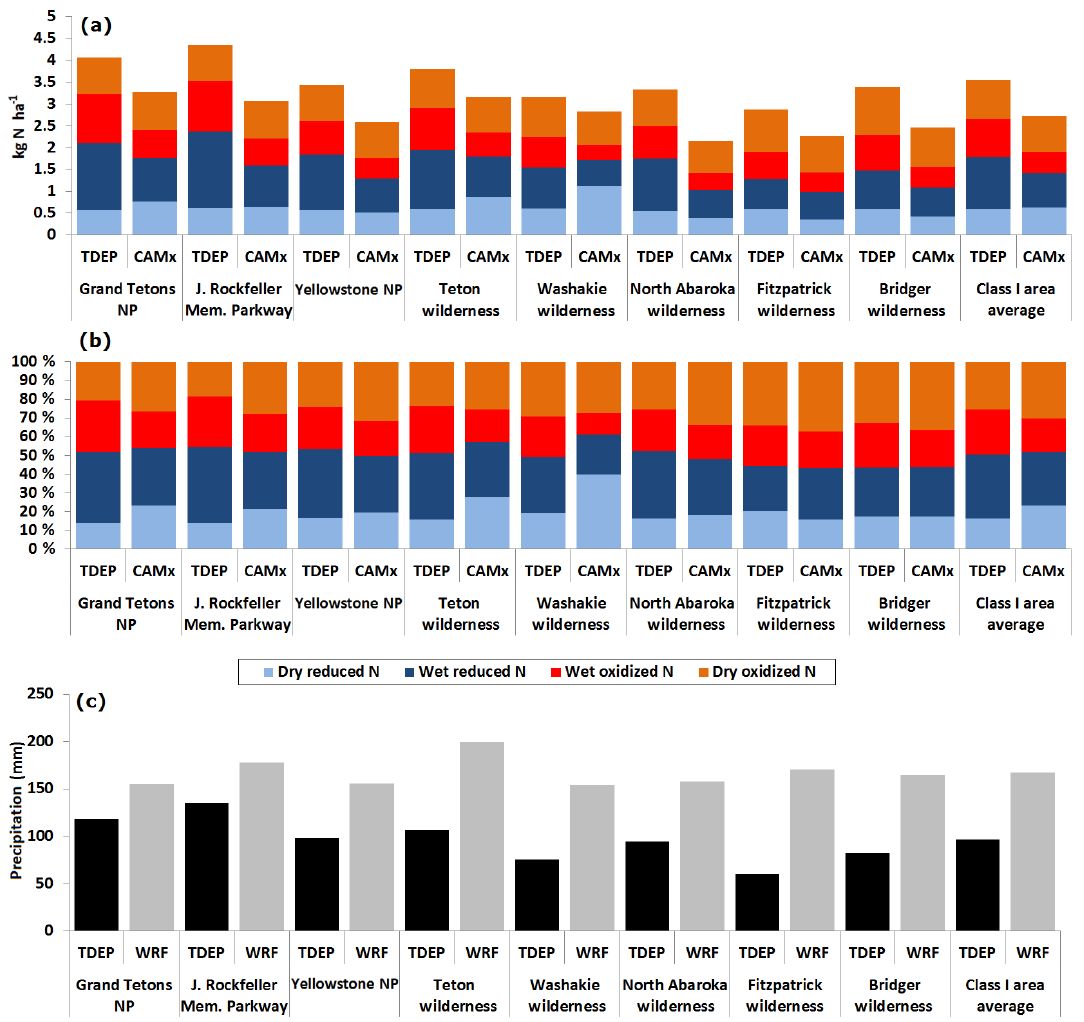
Figure 5. Annual nitrogen deposition budgets as an absolute (a) and as a percentage (b) as well as annual precipitation amounts (c) from the NADP Total Deposition Map (TDEP) and corresponding CAMx (Comprehensive Air Quality Model with extensions) and WRF (Weather Research and Forecasting model) simulation results in 2011 at eight Class I areas across the GYA (the receptor sites on the x axis are arranged from west to east in the GYA; see Fig. 2). The reported CAMx dry and wet N r deposition values at the eight Class I areas are the average of the simulation values at corresponding grid cells for each